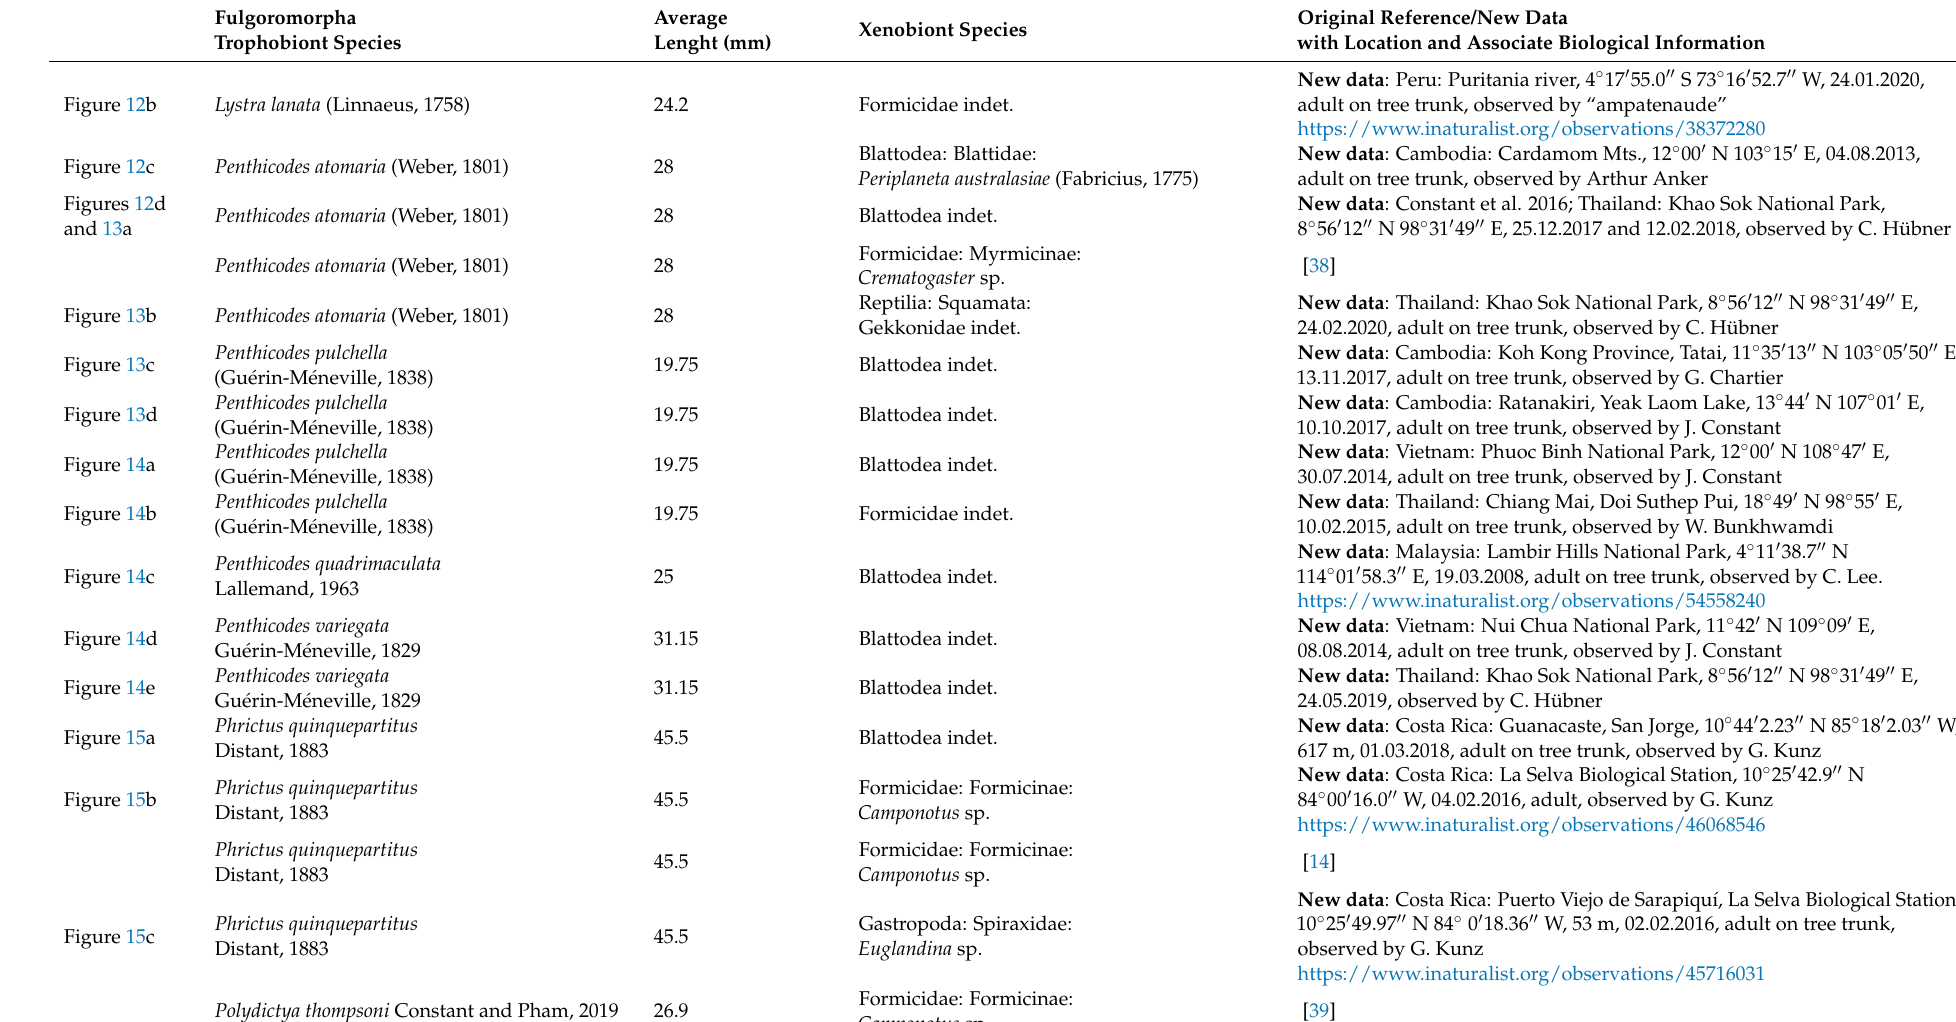
Figure 12b Figure 12c Penthicodes atomaria (Weber, 1801)